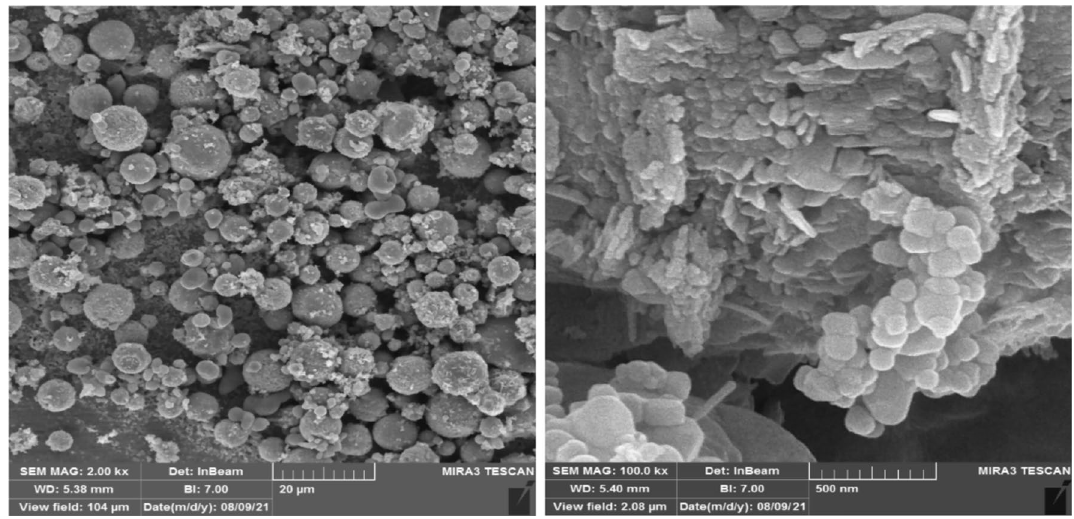
Figure 7. The SEM images of prepared HPW@Fe 3 O 4 –Al 2 O 3 –CS–CG catalyst.